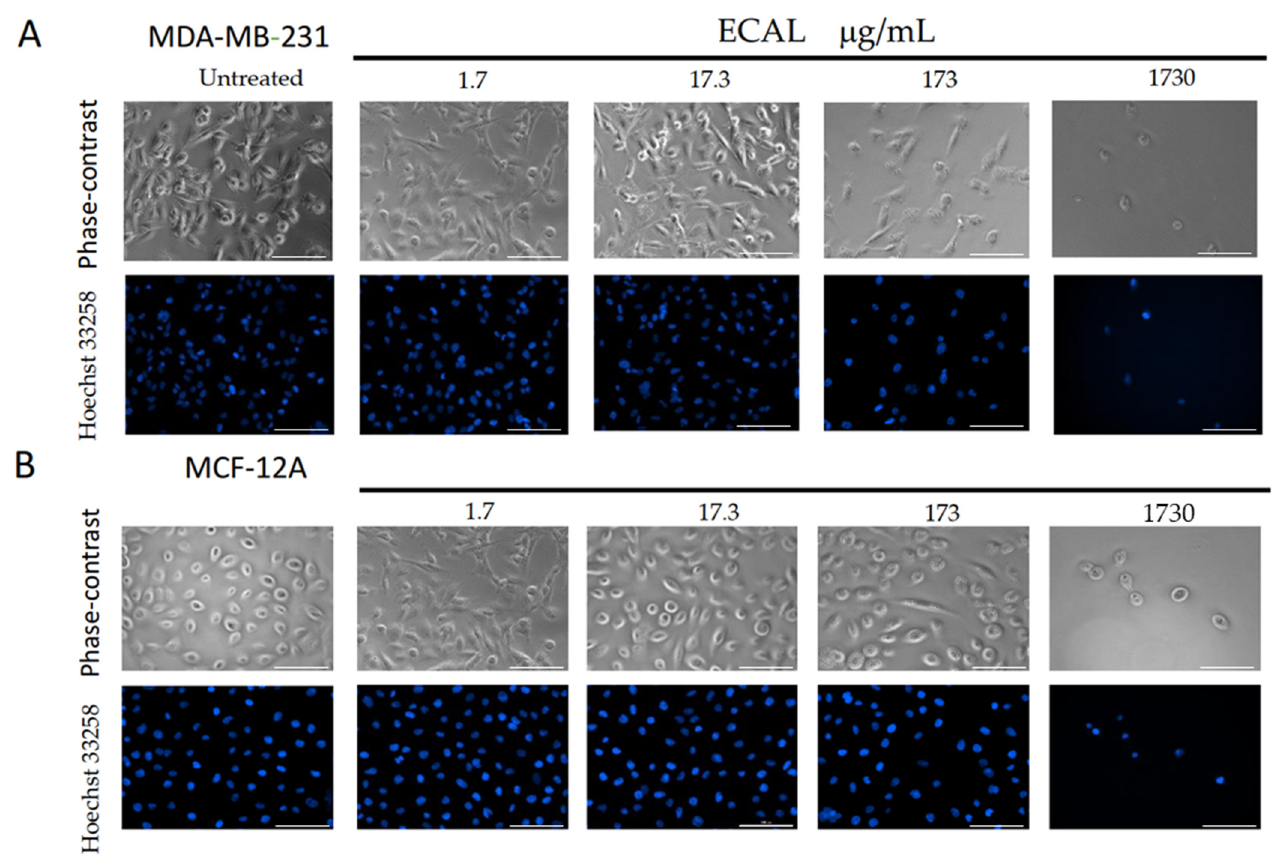
Figure 2. Morphological changes induced by increasing concentrations of the hydroethanolic extract of C. album leaves (ECAL) (1.7–1730 μ g/mL) incubated for 24 h in ( A ) MDA ‐ MB ‐ 231 cells or ( B ) MCF ‐ 12A cells. Upper panel—representative images from five independent experiments obtained under an objective lens of a phase ‐ contrast of the Lionheart microscope; lower panel—representative images from five independent experiments with nuclei stained with Hoechst 33258 (blue) obtained under an objective lens of a Lionheart microscope. Scale bar = 100 μ M.